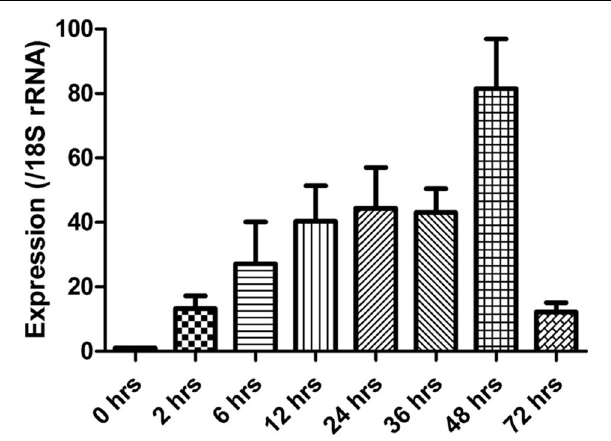
FIGURE 4 | Relative expression of the cgd5_4590 gene in HCT-8 cell culture of Cryptosporidium parvum after the normalization of Ct values of qPCR with data from the 18S rRNA gene of C. parvum. Data shown are mean ± SD from three replicate assays.